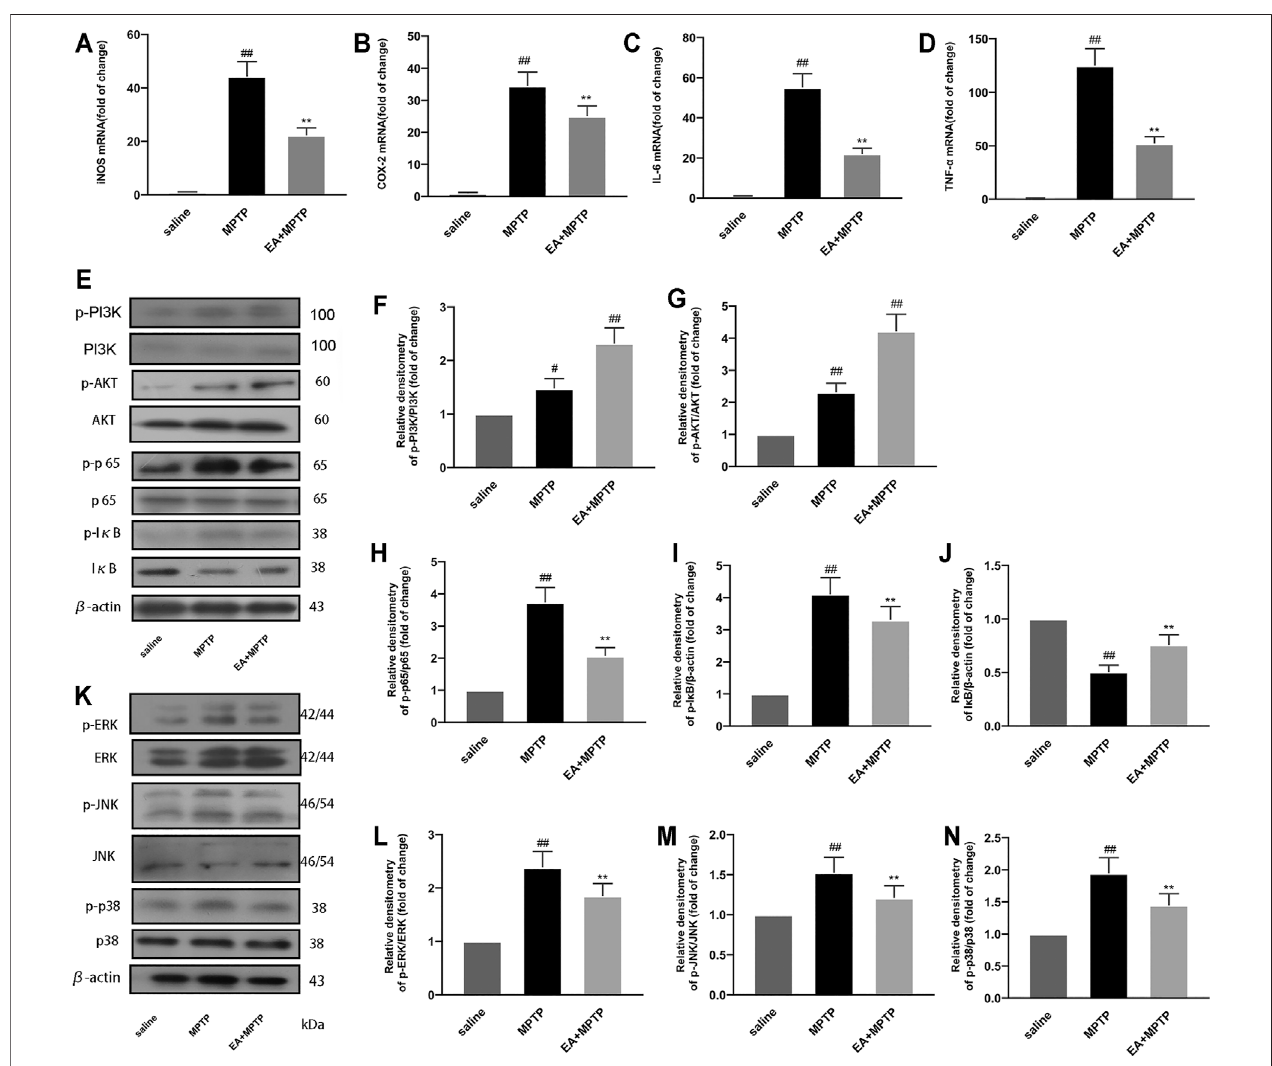
FIGURE 8 | EA inhibits MPTP-induced in fl ammation in a mouse model of PD. We obtained mouse midbrain tissue. The mRNA expression of in fl ammatory mediators[iNOS (A) ,COX-2 (B) ,IL-6 (C) ,andTNF- α (D) ]wasdetectedusingquantitativePCRexperiment. TheproteinexpressionofPI3K/Akt (E – G) ,NF- κ B (E – J) ,and MAPK (K – N) pathways was detected by Western blot experiment. Results are represented as means ± SD ( n (cid:1) 4). ## p < 0.01 vs. saline group. **p < 0.01 vs. MPTP group.